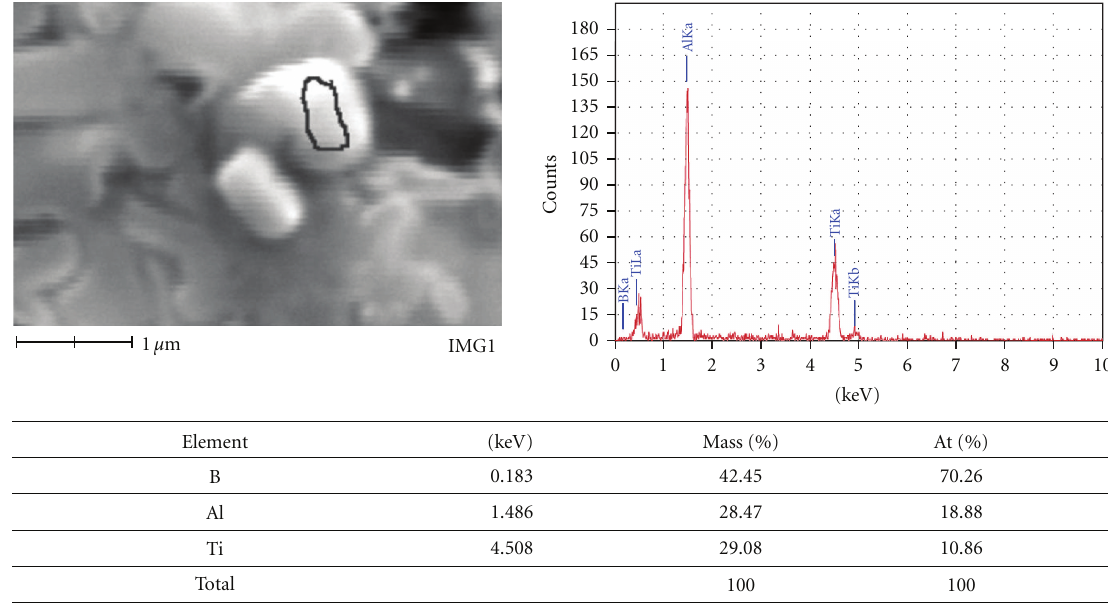
Figure 5: EDX spectrum and elemental mapping on TiB 2 particle. Table 1: Data of tensile test conducted on cast Al, Al-MMCs and gray cast iron. Sr.